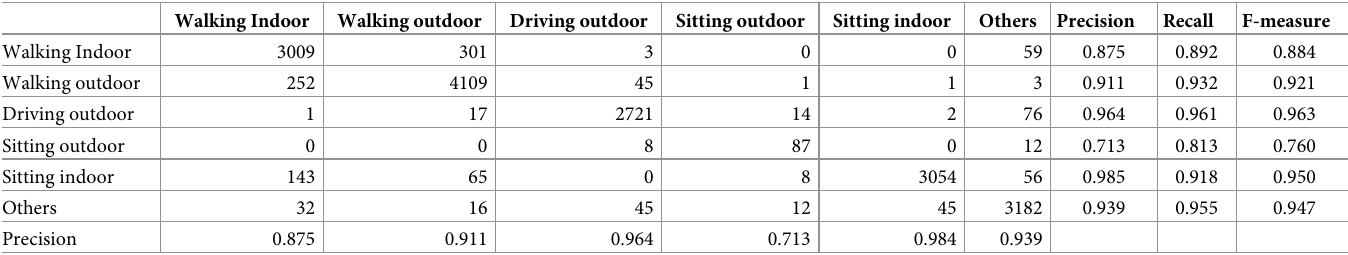
Table 4. Evaluation results for 90% manually annotated data where 70% were used as training and 30% as a testing dataset. Walking